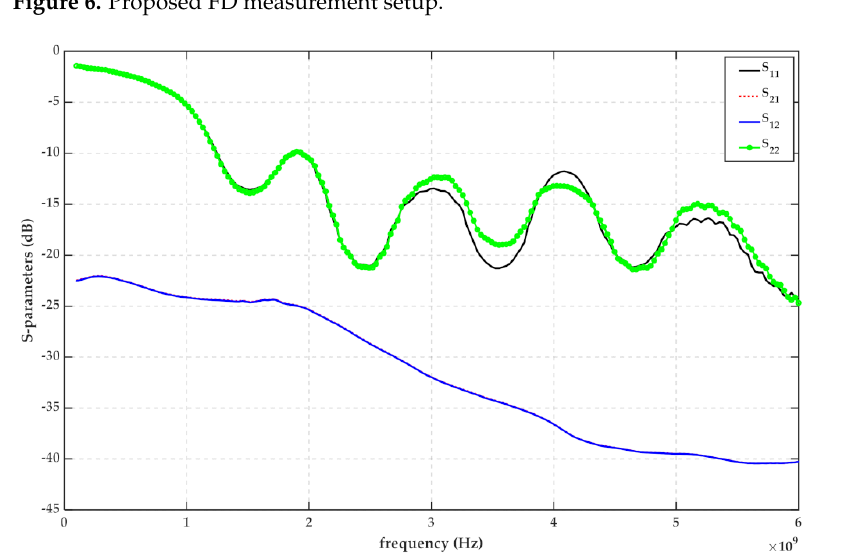
Figure 6. Proposed FD measurement setup.